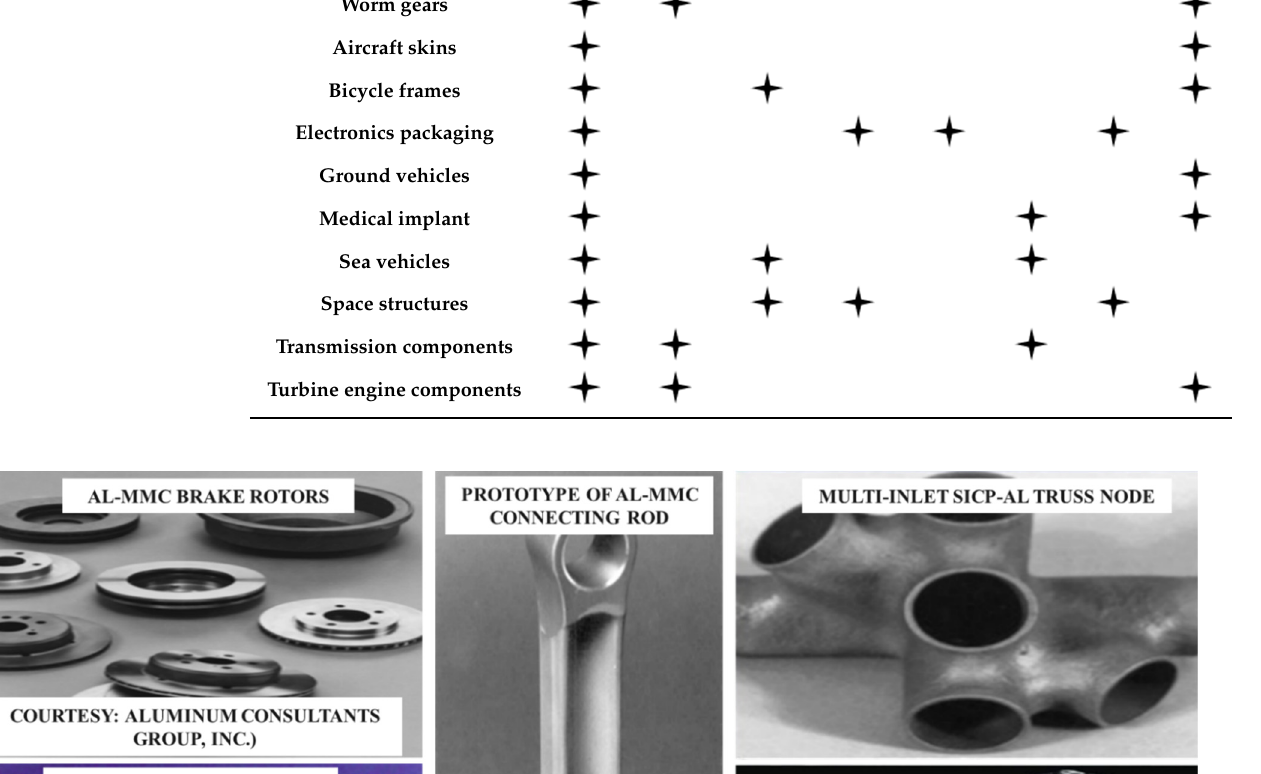
Table 4. Applications of Al-based MMCs [37].